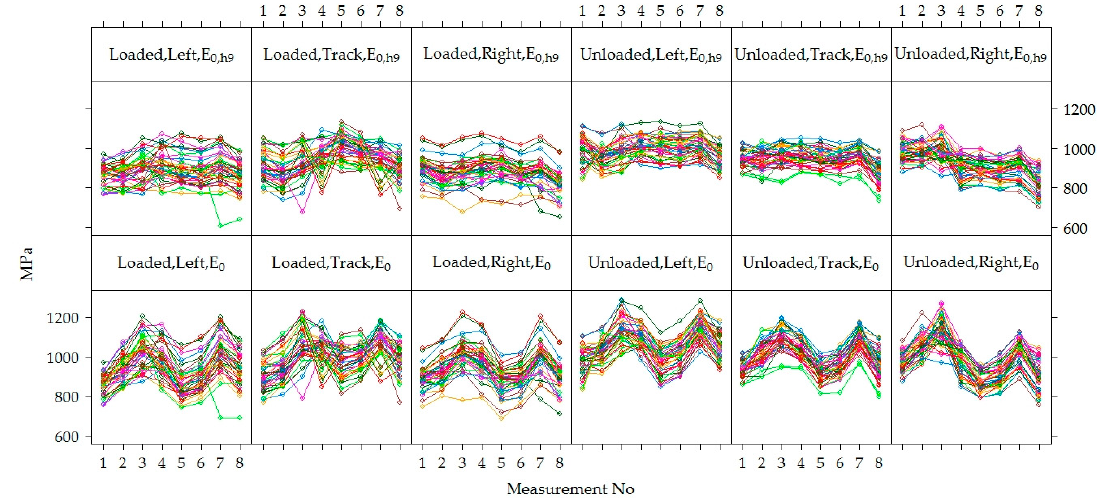
Figure 19. The dynamics of E 0 and E 0,h9 values of each point of measurement in unloaded and loaded lanes by analyzing the data of all road PS together.